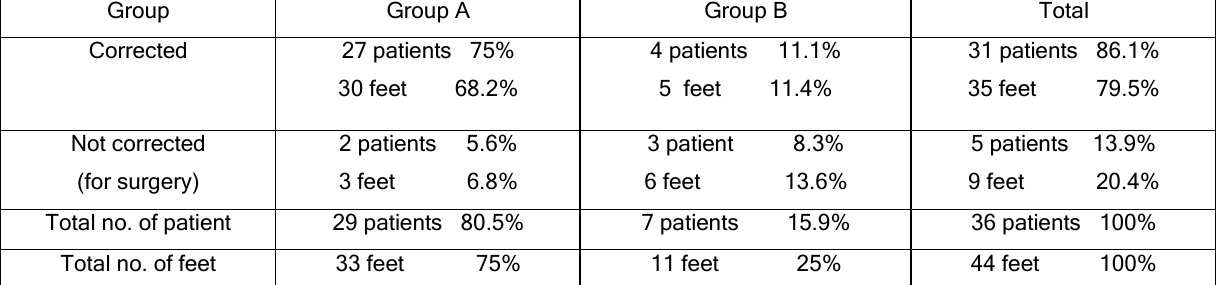
Table (3): 24weeks follow up results